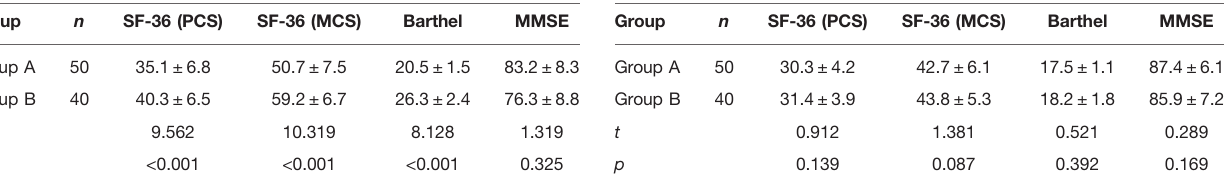
TABLE 5 | Comparison of life quality and mental state at 6 months postoperative between two group (score, (cid:1) x + S ).